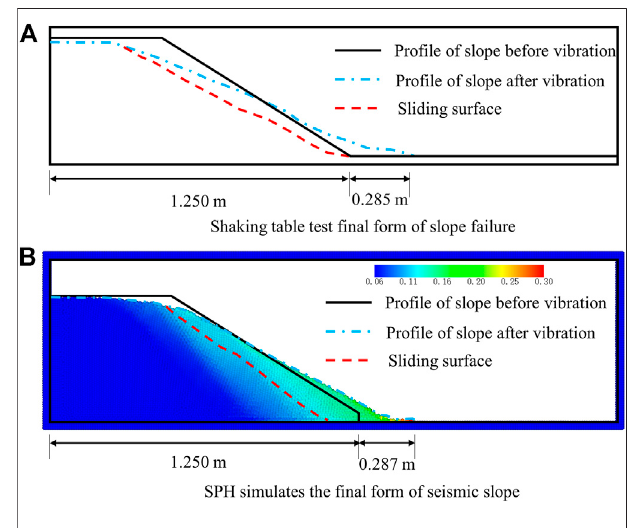
FIGURE 4 | Final shape comparison of slope (unit: